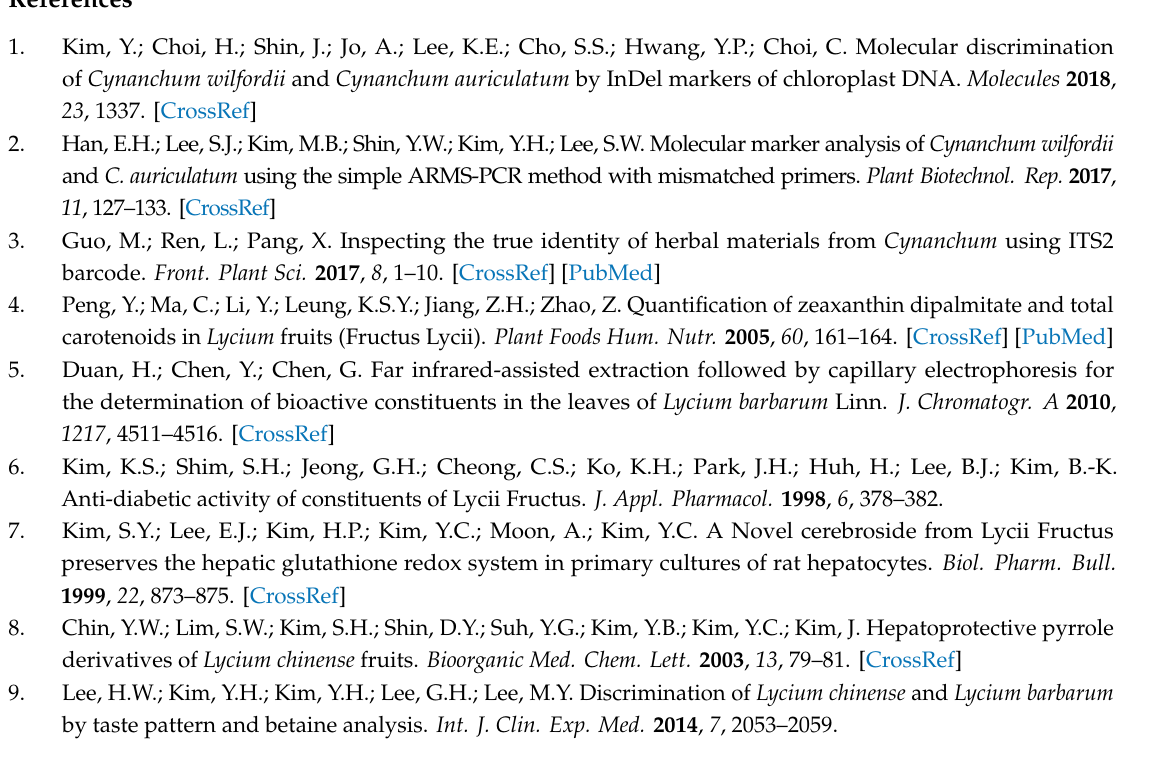
Supplementary Materials: The following materials are available online. 1 H- and 13 C-NMR spectra of compounds 1 and 2 (Figures S1–S4), commercially available Lycii Fructus, and corresponding LC chromatograms (Figures S5 and